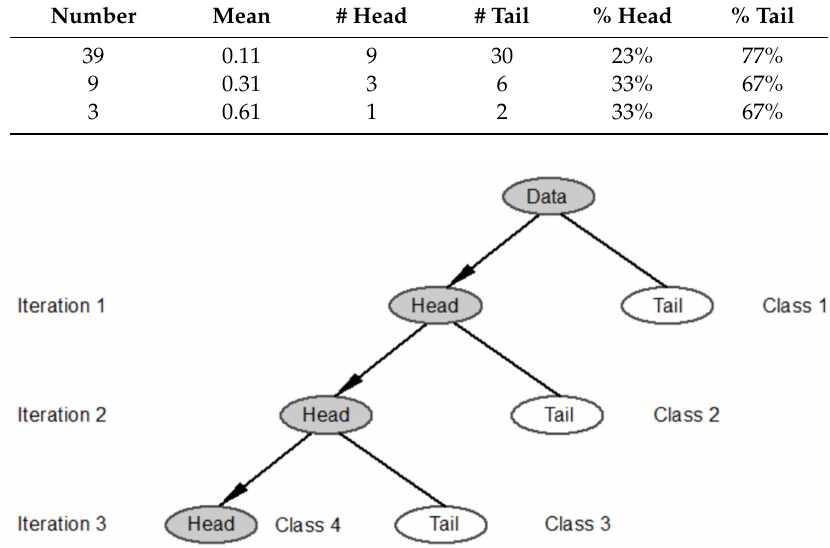
Table 2. Statistics of the head / tail breaks process of the 39 numbers.